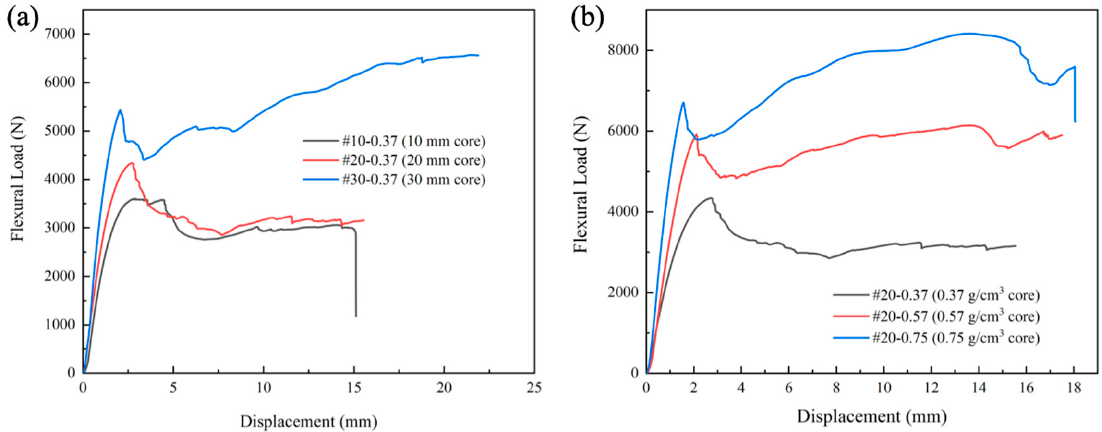
Figure 3. Flexural load–displacement curves of three-point bending test of aluminum foam sandwich panels: ( a ) different core thickness; ( b ) different core density.